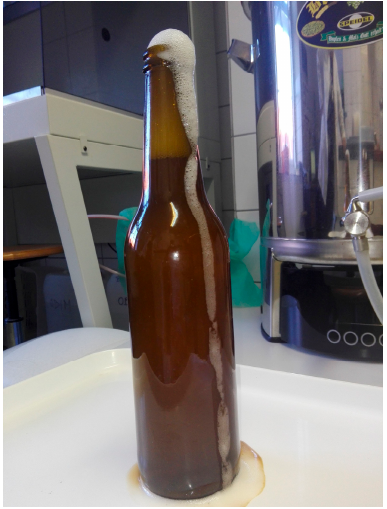
Figure 4 Example of beer gushing. Figure 4. Example of beer